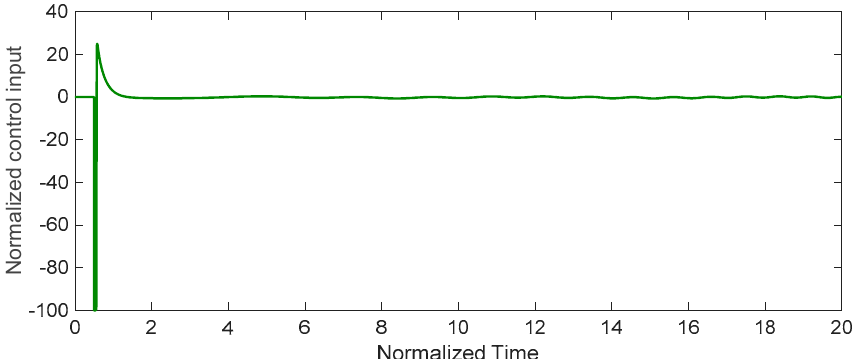
Figure 8. The states of the system based on the proposed control scheme in the presence of unknown disturbance.